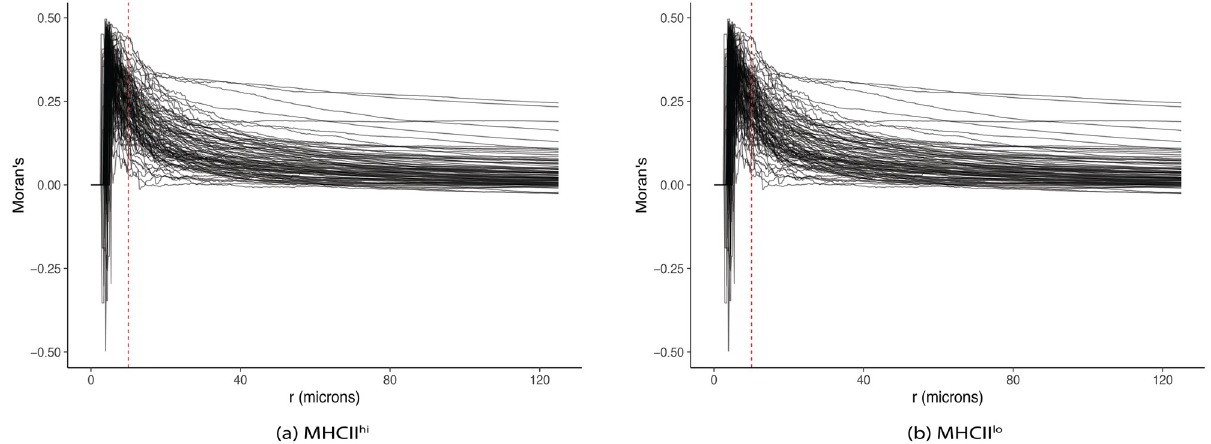
Fig 2. Moran’s I correlation between tumor and stromal cells using MHCII in NSCLC. (A) MHCII hi group. (B) MHCII lo group. Patients with more than 5% tumor cells positively expressed with MHCII were classified into MHCII hi group. Negative Moran’s I values indicate an inverse relationship in MHCII expression between tumor and stromal cells. Moran’s I values above 0 suggest a direct relationship in MHCII expression between tumor and stromal cells. Dashed red vertical line in each panel corresponds to distance r = 10 μ m.